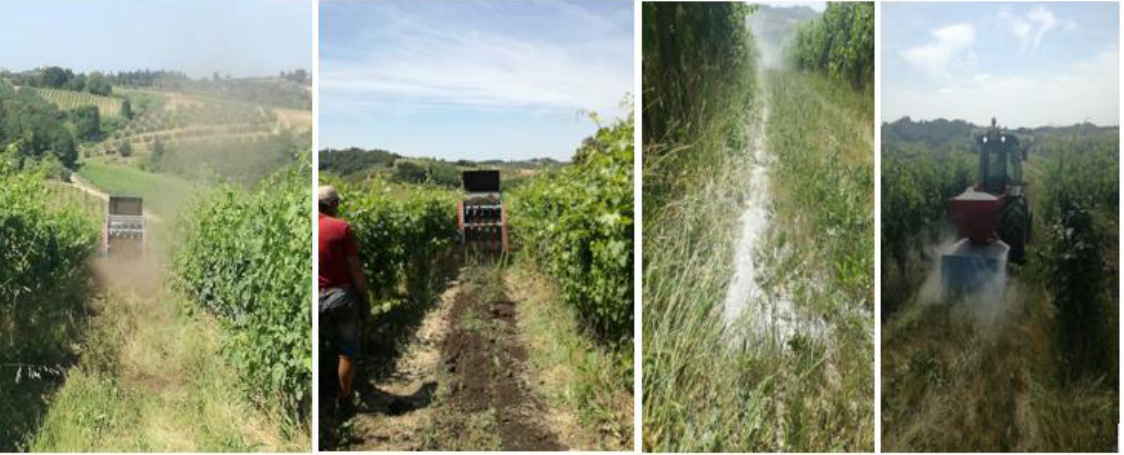
Figure 15. Treatment applications at CMM.